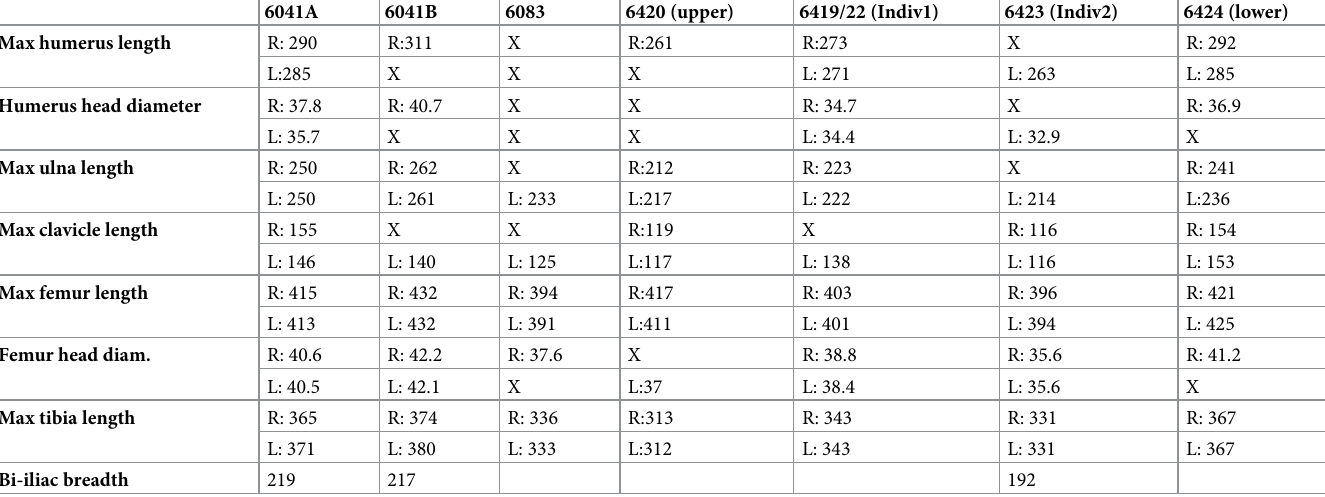
Table 3. Selected post-cranial measurements of the Lagoon Beach adult skeletons (mm). Values for SAM-AP 6083, an adolescent, are from long bones with fused epiphyses. Values for SAM-AP 6420, a younger adolescent, are estimates that include the yet-unfused